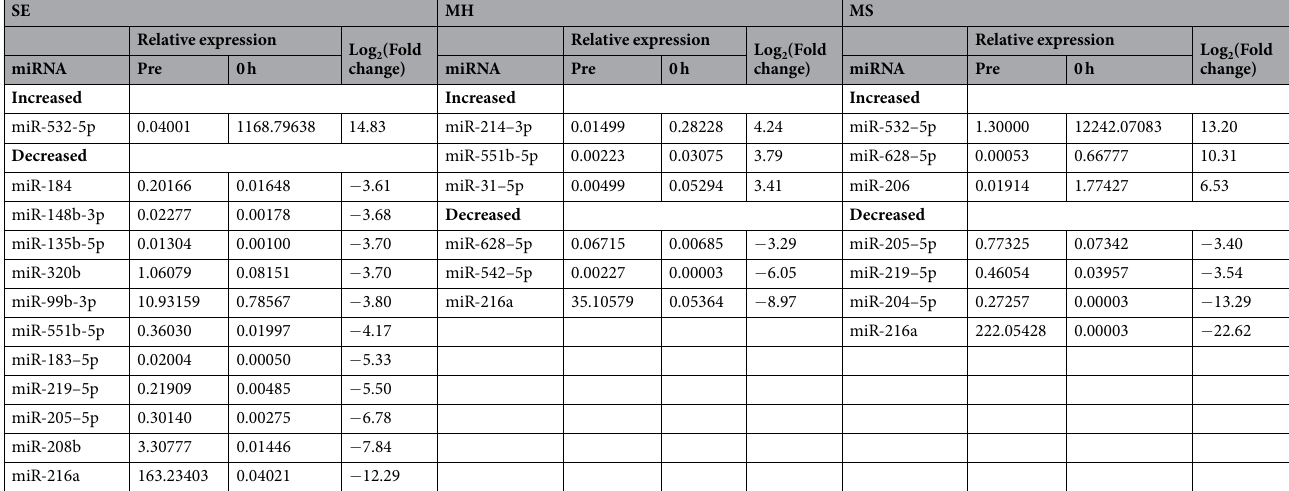
Table 2. Markedly altered miRNAs in pooled plasma samples from baseline (Pre) compared with those from immediately after exercise (0 h) in the SE, MH and MS groups as determined by TLDA. The relative expression was expressed based on the formula (2 − △ Ct ) and the Ct values were normalized on the calculated mean Ct value of the Let-7d/g/i of each pooled sample ( Δ Ct). Fold changes of miRNAs species were calculated using the 2 −ΔΔ Ct method.